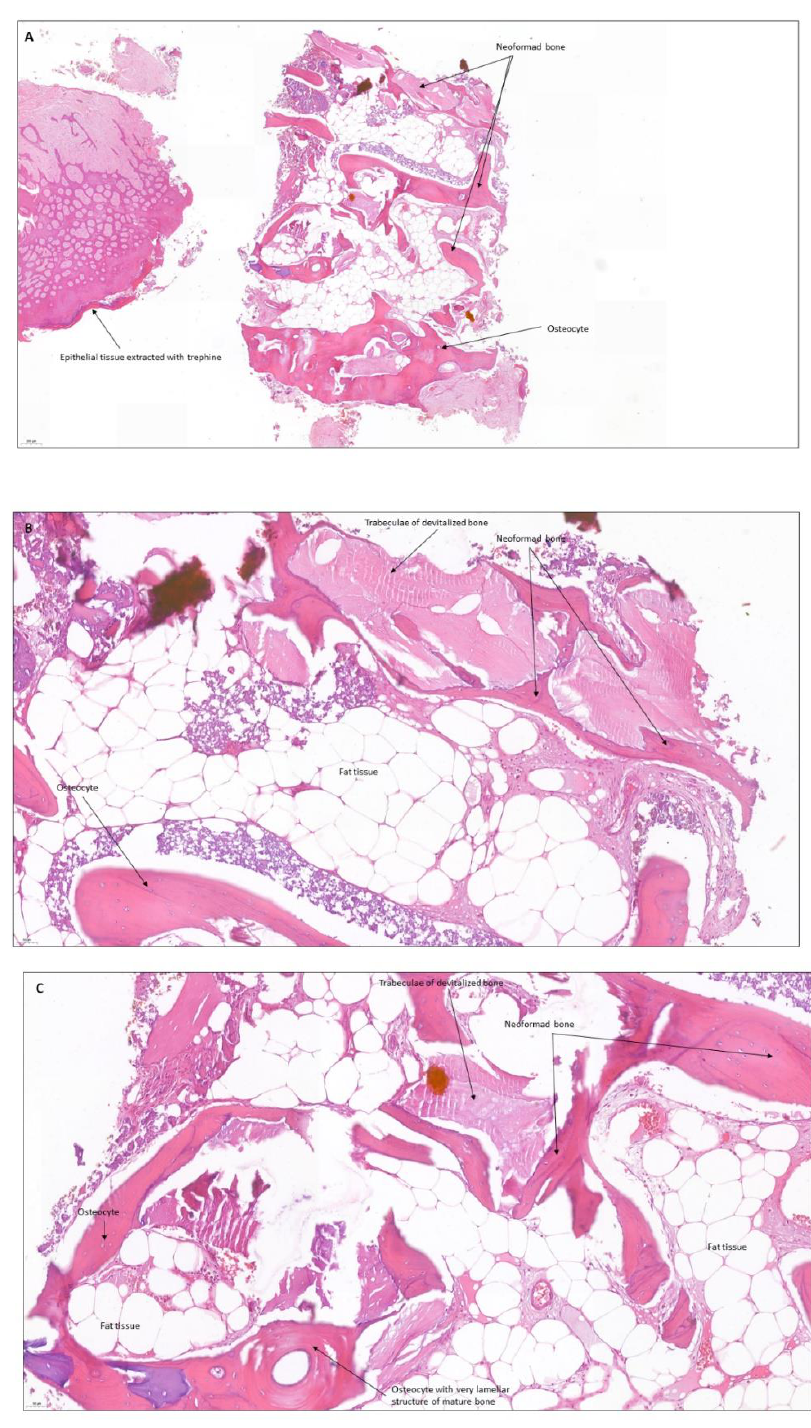
Figure 23. Abundant newly formed bone and some trabeculae of devitalized bone in ( A ) at 50× and in ( B ) and ( C ) at 200×. Total bone length of 3.56 and newly formed bone of 3.01